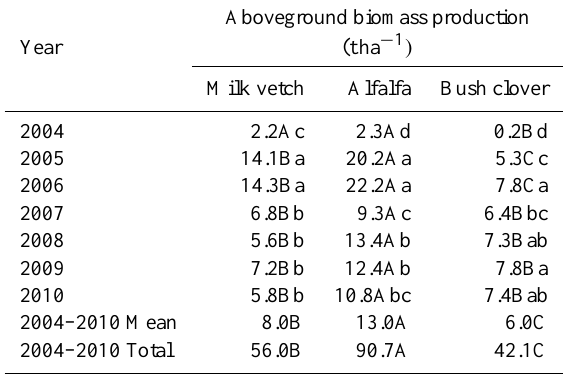
Table 1. Annual aboveground biomass production of the three legume species, milk vetch, alfalfa and bush clover, from 2004 to 2010. Adopted from Guan et al. (2013) and used with permission. Aboveground biomass